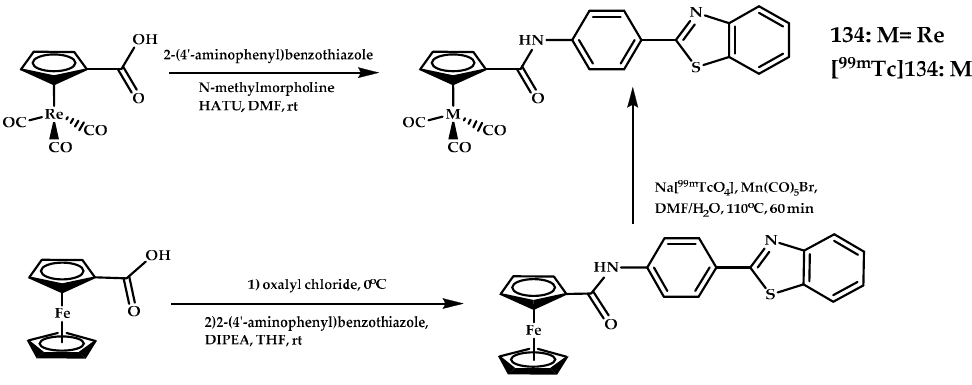
Figure 30. 2-(4 ′ -aminophenyl)benzothiazole-based 99m Tc–radioagent [ 99m Tc]134 and its Re(III) analogue 134 , designed for SPECT imaging of A β